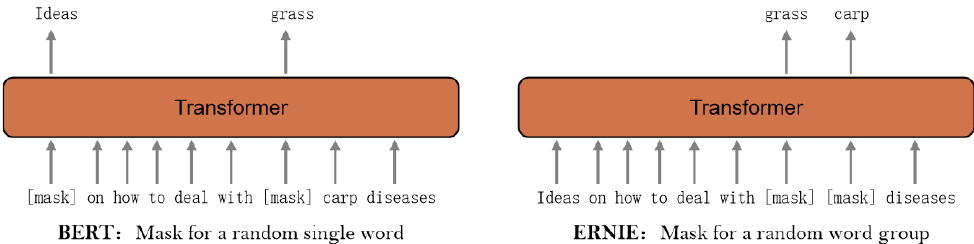
Figure 1. Difference between ERNIE and BERT masking methods.